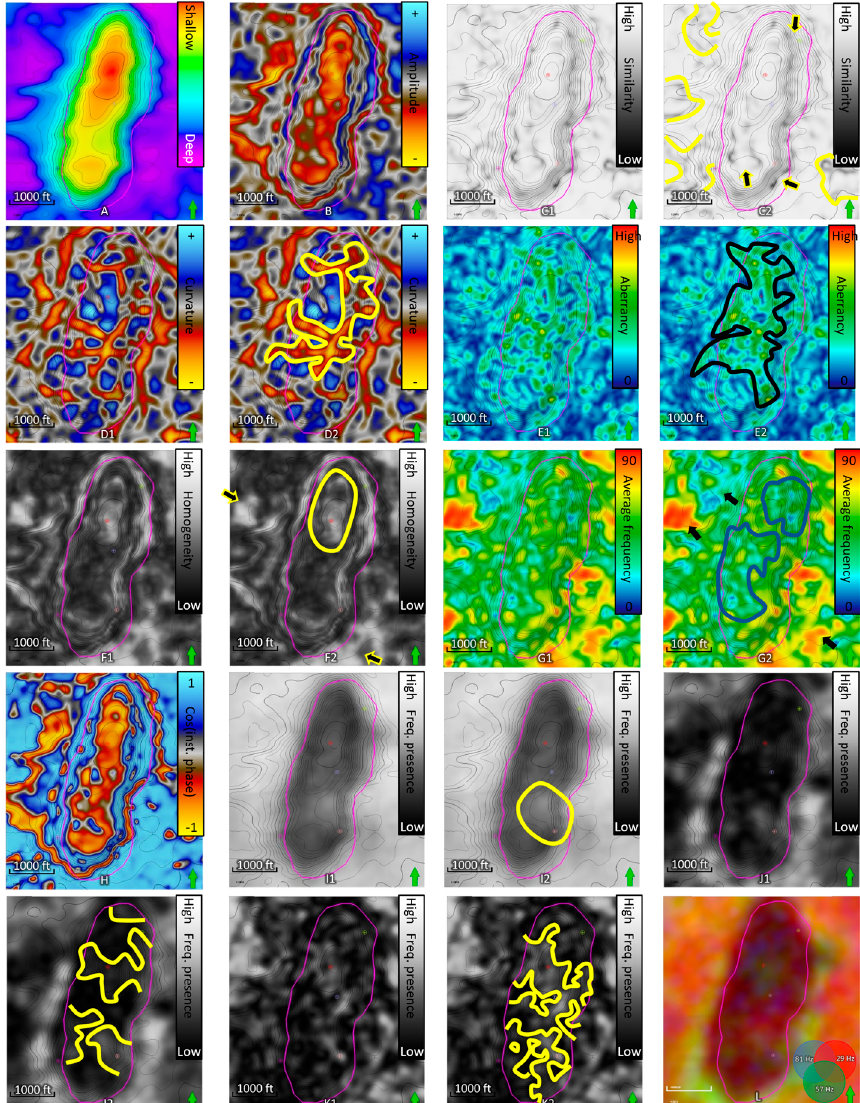
Figure 5. All images, excluding ( L ), were extracted onto the Brown horizon. ( A ) TWT map. ( B ) Pre-stack time migrated (PSTM) amplitude. ( C1 ) Energy ratio similarity. ( C2 ) Interpreted energy ratio similarity. ( D1 ) Negative curvature. ( D2 ) Interpreted negative curvature. ( E1 ) Aberrancy. ( E2 ) Interpreted aberrancy. ( F1 ) gray level co-occurrence matrix (GLCM) homogeneity. ( F2 ) Interpreted GLCM homogeneity. ( G1 ) Average frequency. ( G2 ) Interpreted average frequency. ( H ) Cosine of instantaneous phase. ( I1 ) Continuous wavelet transform (CWT) spectral decomposition at 29 Hz. ( I2 ) Interpreted CWT spectral decomposition at 29 Hz. ( J1 ) CWT spectral decomposition at 57 Hz. ( J2 ) Interpreted CWT spectral decomposition at 57 Hz. ( K1 ) CWT spectral decomposition at 81 Hz. ( K2 ) Interpreted CWT spectral decomposition at 81 Hz. ( L ) RGB (red-green-blue) blending of the three CWT spectral decomposition volumes displayed at 430 ms where red is 29 Hz, green is 57 Hz, and blue is 81 Hz.